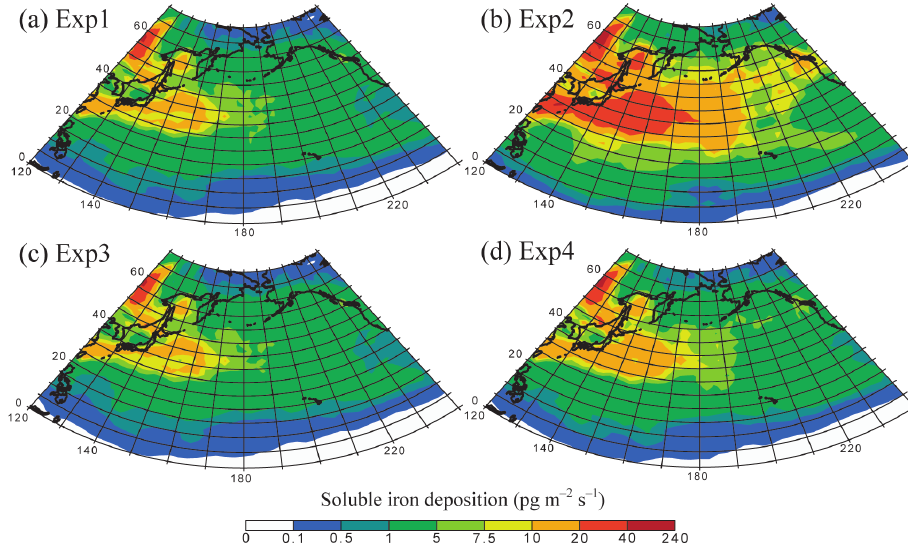
Fig. 8. Average soluble iron deposition (pg m − 2 s − 1 ) to the ocean from dust source for (a) hematite internally mixed with the alkaline dust (Exp1), (b) hematite externally mixed with the alkaline dust (Exp2), (c) illite internally mixed with the alkaline dust (Exp3), and (d) illite externally mixed with the alkaline dust (Exp4) for fine mode during April 2001.